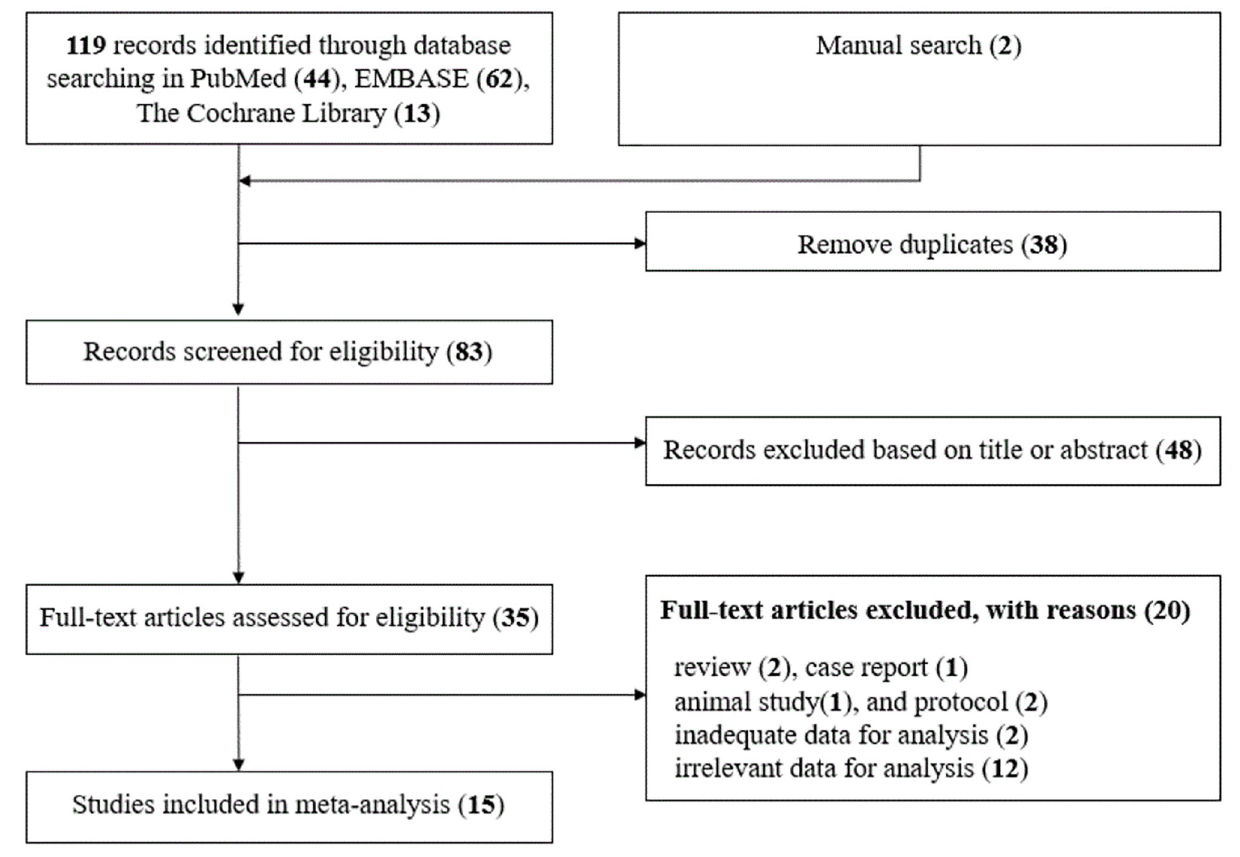
Fig 1. Flow chart of study selection